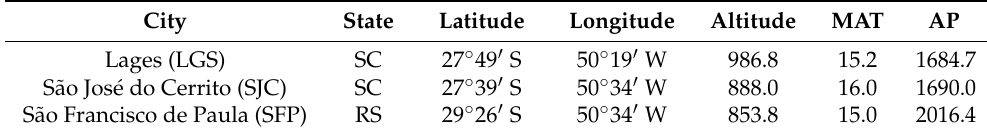
Table 1. Climate characteristics of the three study